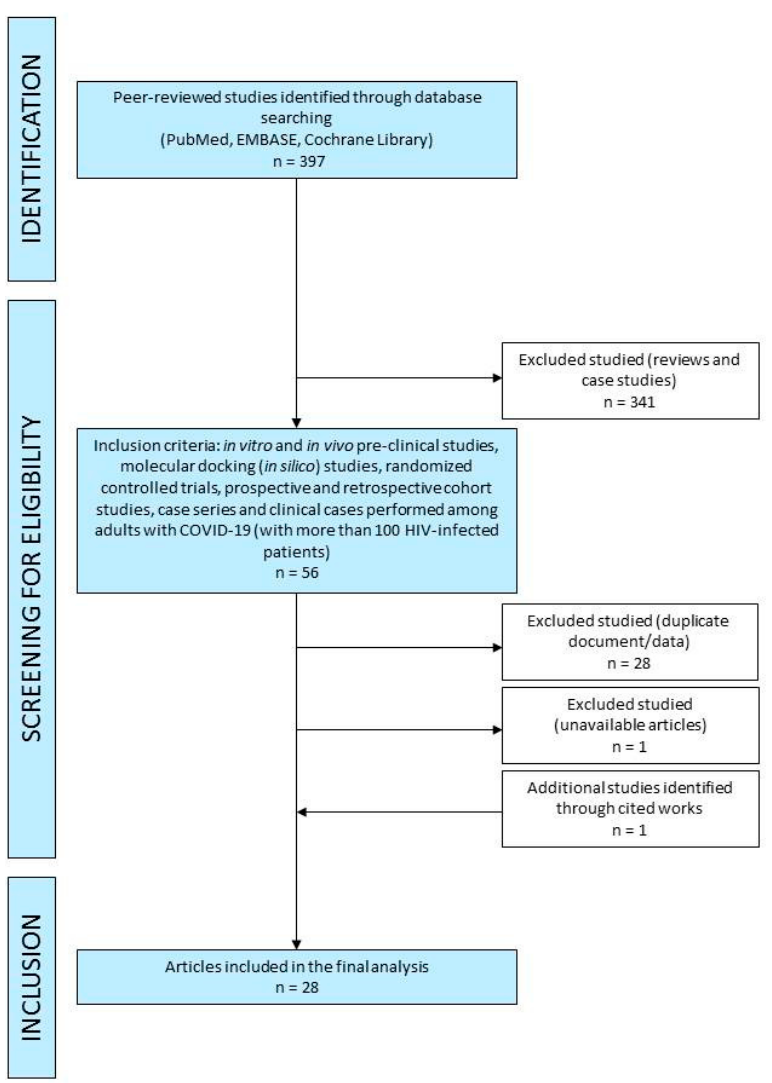
Figure 3. Flow chart of database searching and screening of studies for the systematic review.